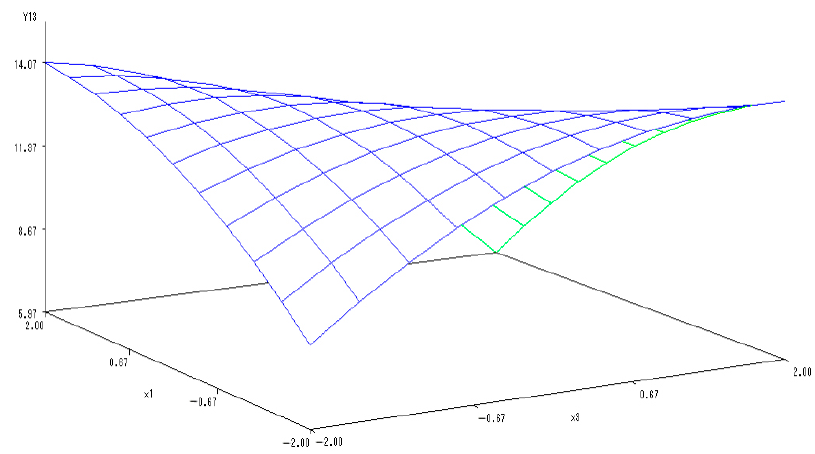
Figure 10. The 3 ‐ D map of mutual effect of N and K fertilizers application on the soluble protein content in melon.